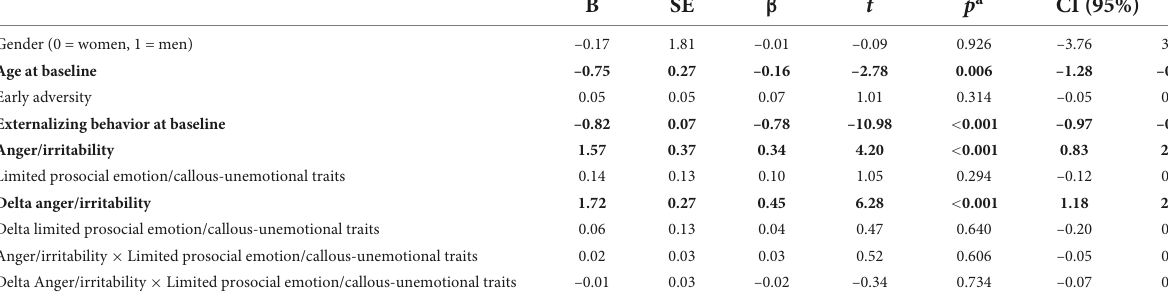
TABLE 5 Prediction of aggravation in externalizing behaviors over time (delta).